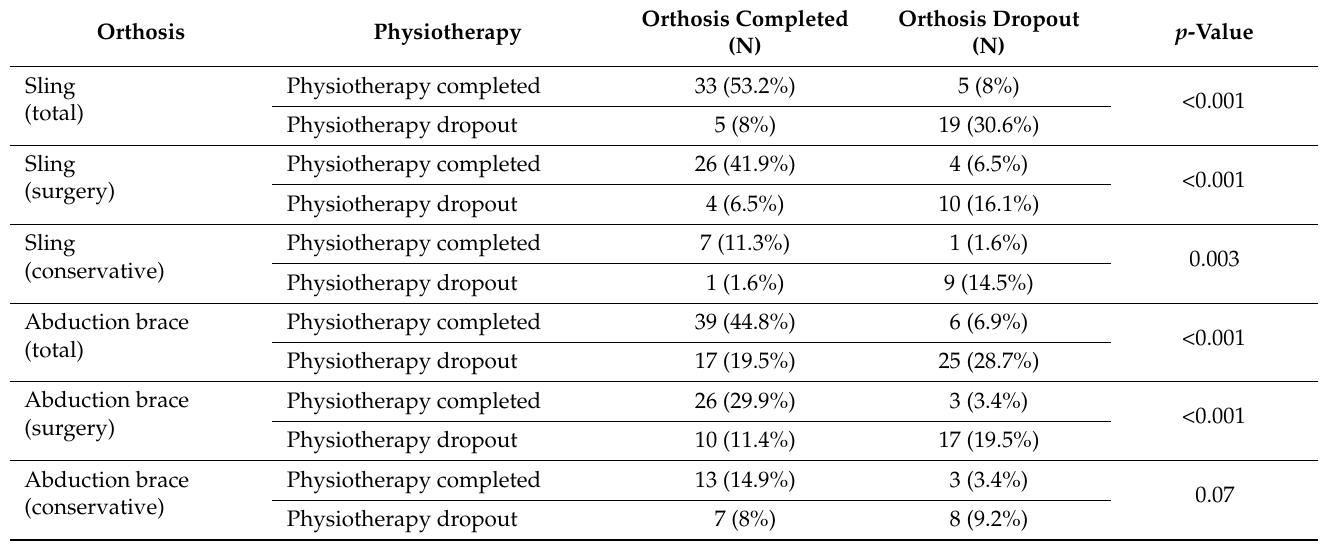
Table 2. Distribution of the number of participants according to compliance collectives.